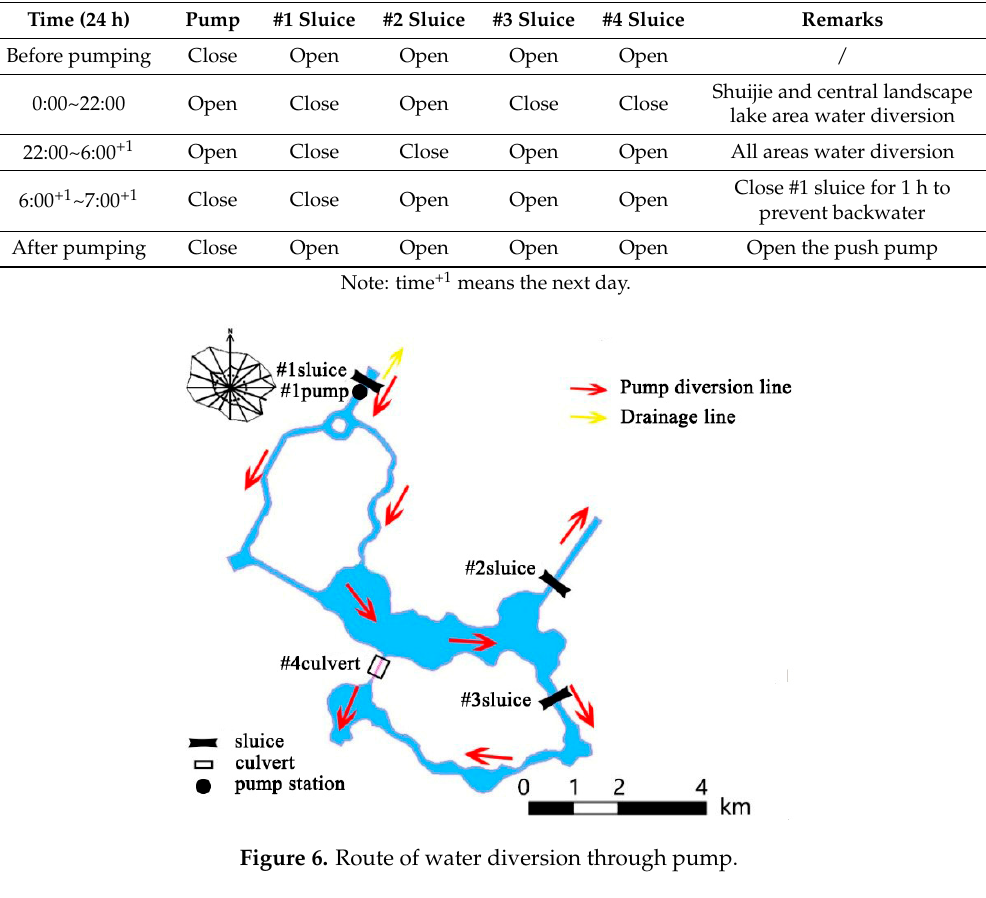
Table 4. “Three sluices and one culvert” scheduling plan during pump diversion.